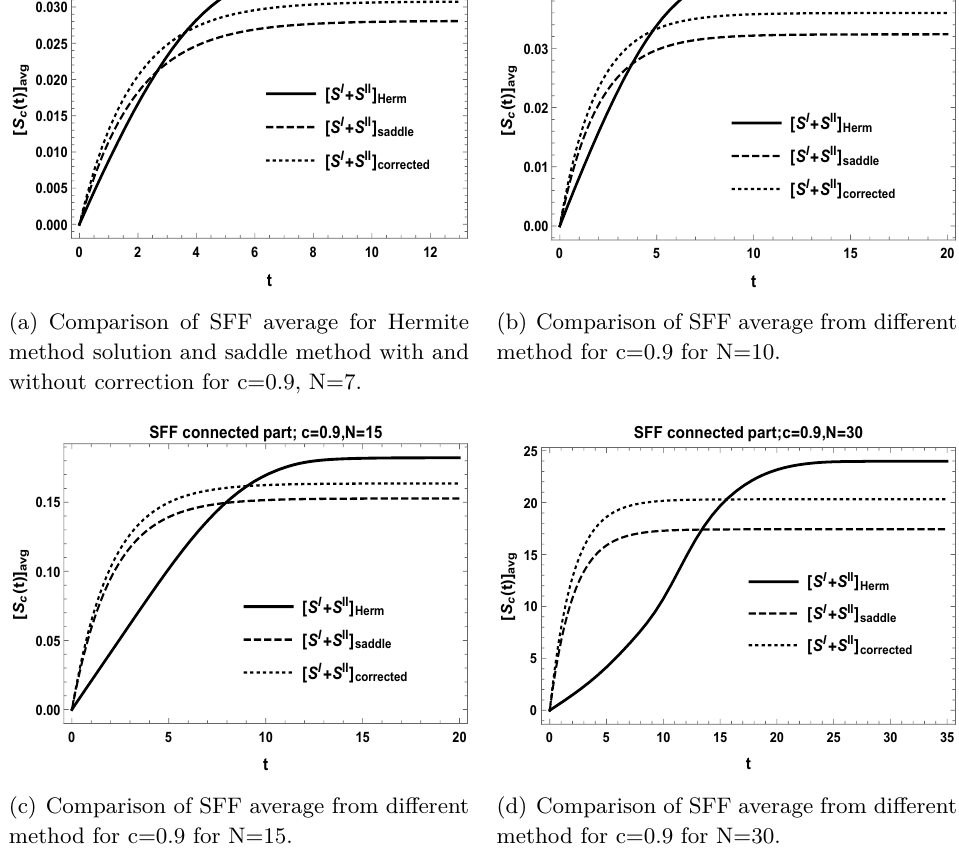
Figure 9 . SFF from saddle point approximation at zeroth order is compared with 1st order correction from saddle point method. Change in saturation value has been